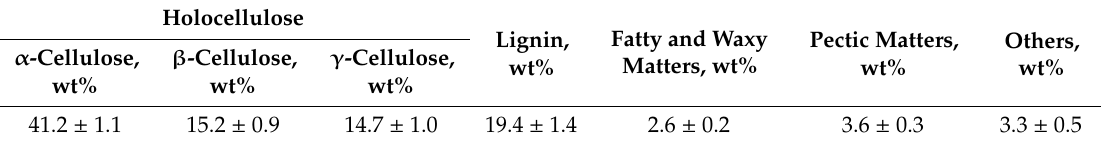
Table 1. Composition of corn waste residue (Each test was performed at least three times and average and standard deviation were